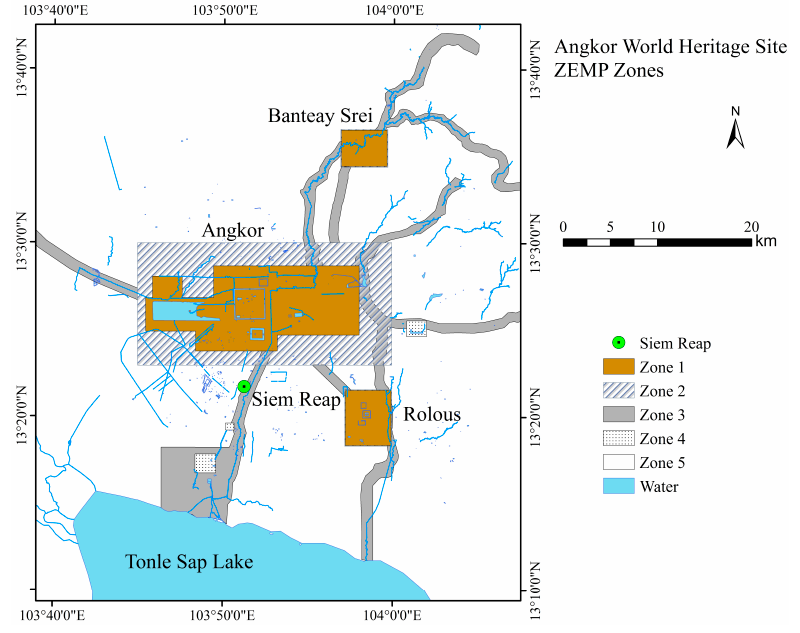
Figure 1. ZEMP zones in the Angkor world heritage